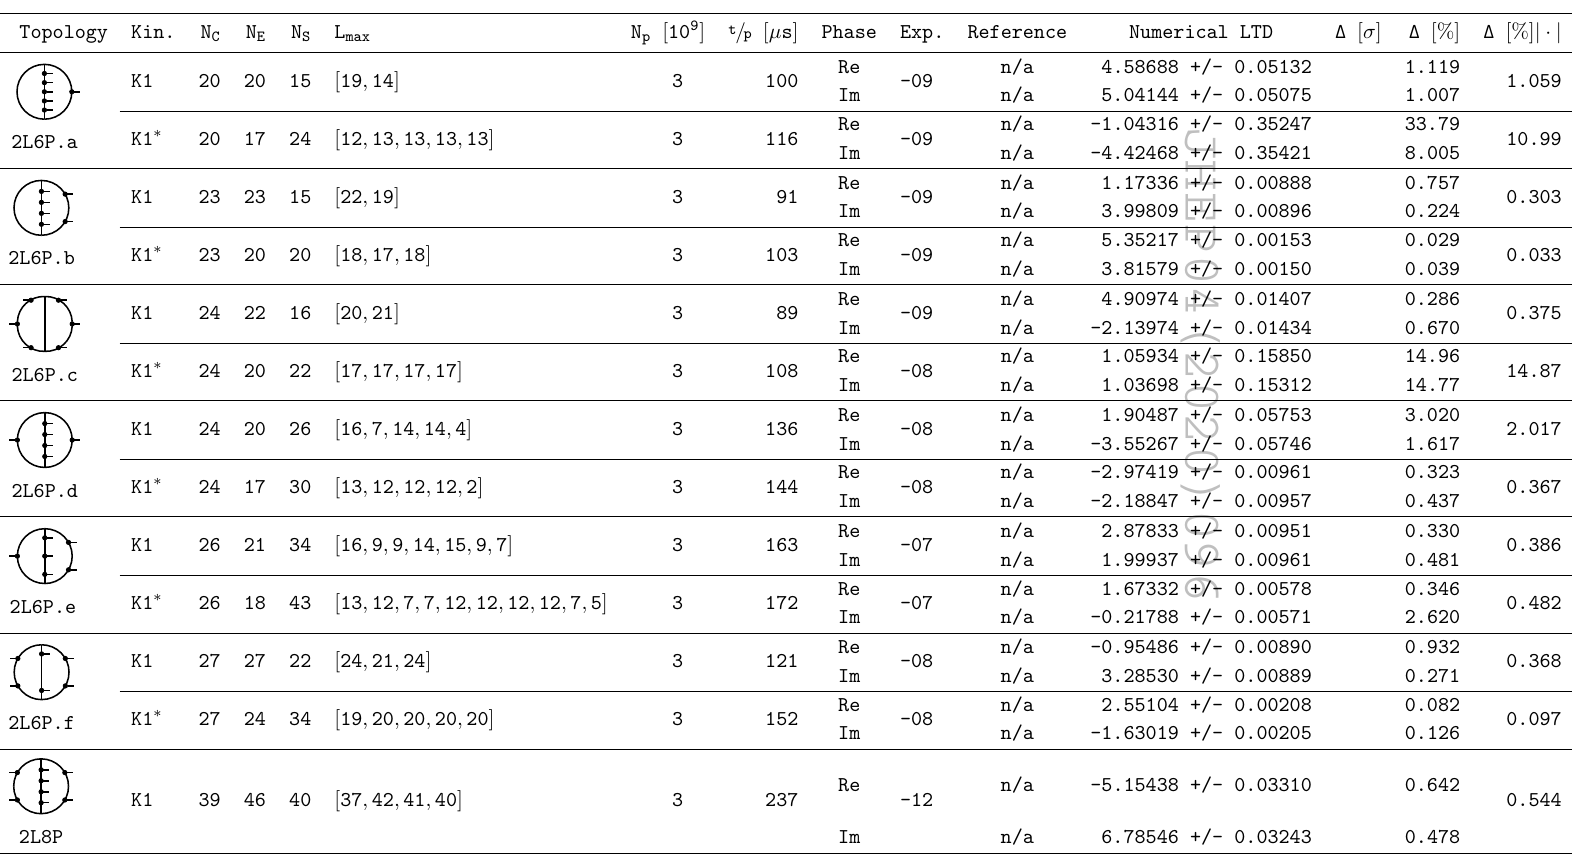
Table 7. Results for two-loop topologies for scattering kinematics (2